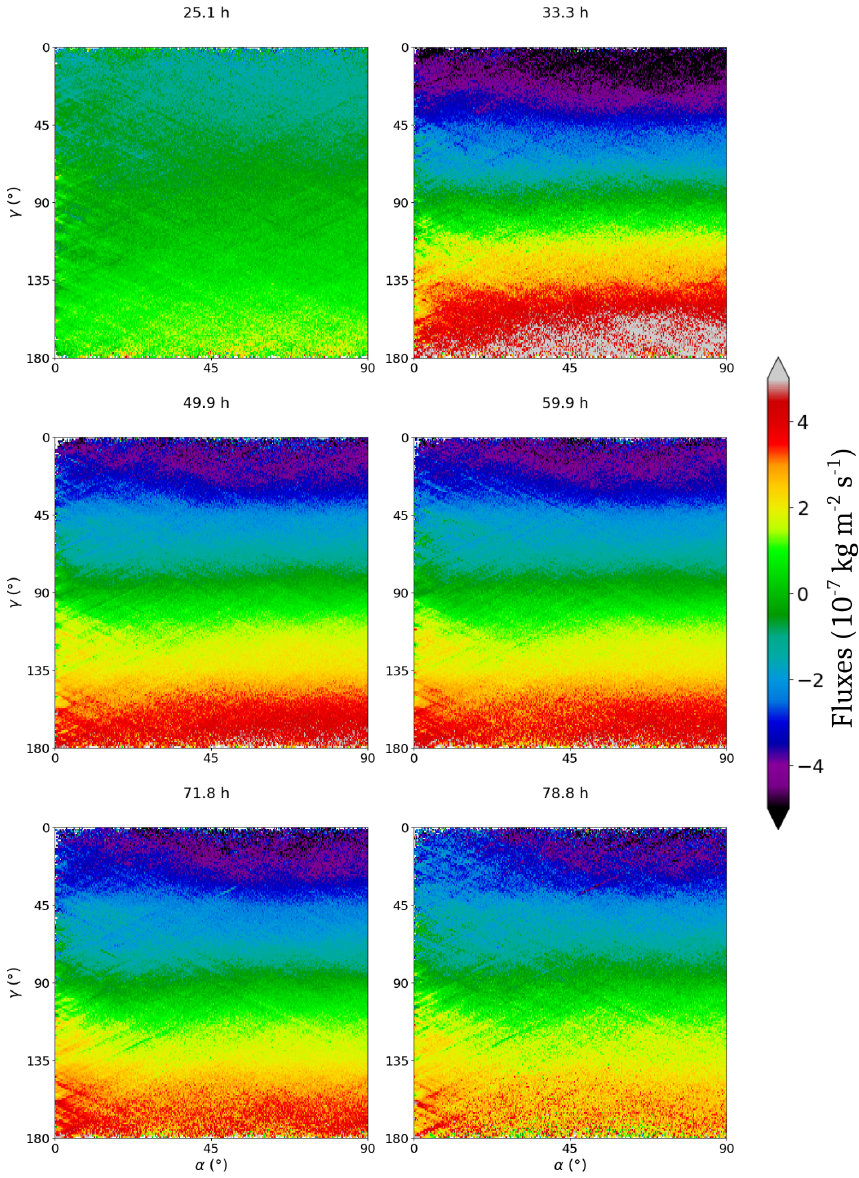
Figure 17. Mean fluxes against α = ( c , n ) and γ = ( z , n )